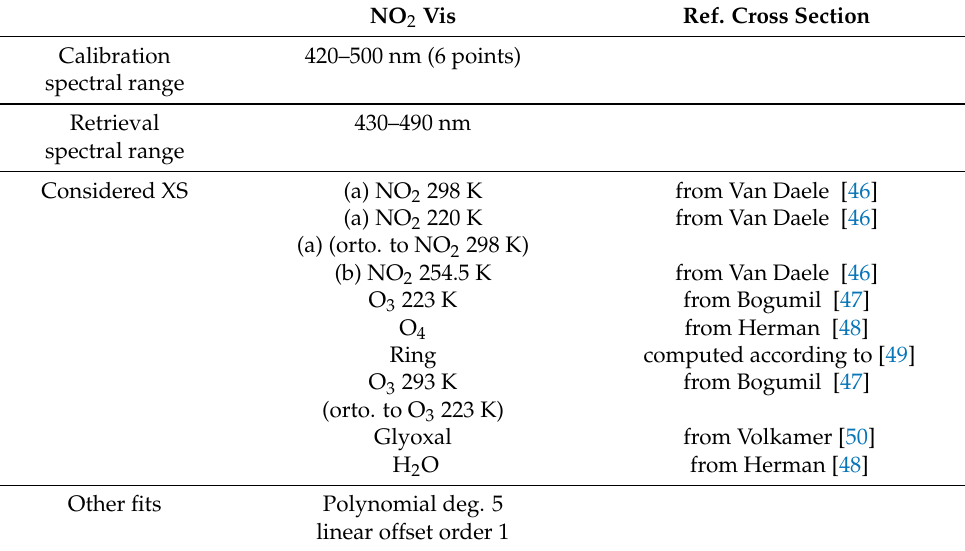
Table A2. QDOAS settings for SkySpec-2D NO 2 SCDs calculations in visible spectral range; “orto.” means that cross sections are orthogonalized with respect another cross section at a different tempera- ture. The NO 2 cross sections used for the measurement campaigns in Bologna and Rome are labeled with (a) and (b),